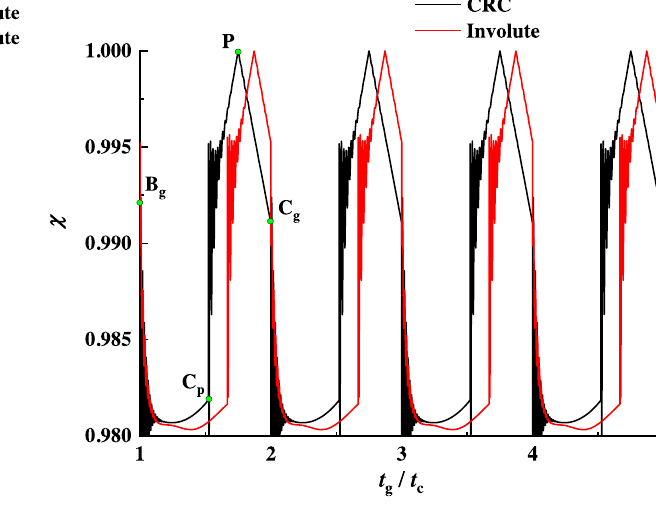
Fig. 13. Sliding friction coef fi cient.